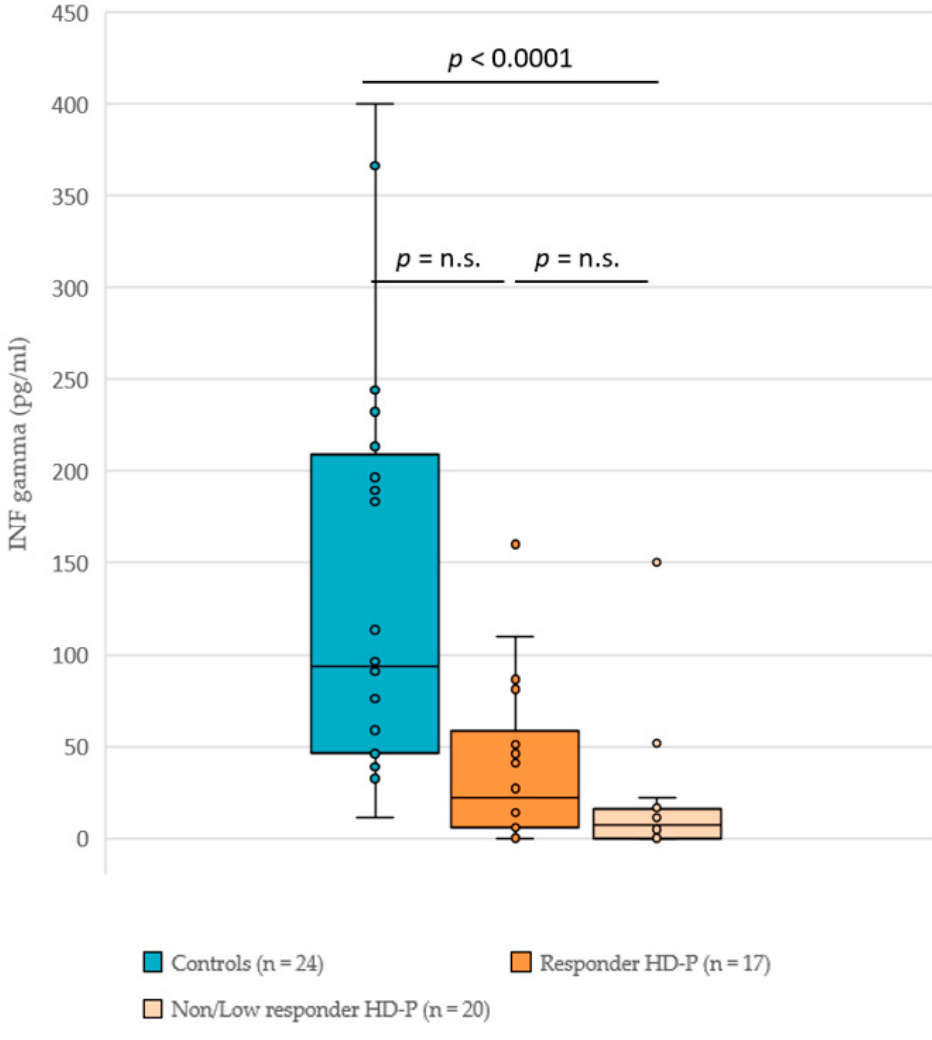
Figure 4. Interferon gamma secretion IGRA titers in controls and HD patients (split into responder and low/non-responder groups) 6–8 weeks after the third vaccine dose. Interferon gamma titers in picograms per ml; HD-P, HD patients; p values < 0.05 were considered significant; n.s., not significant.